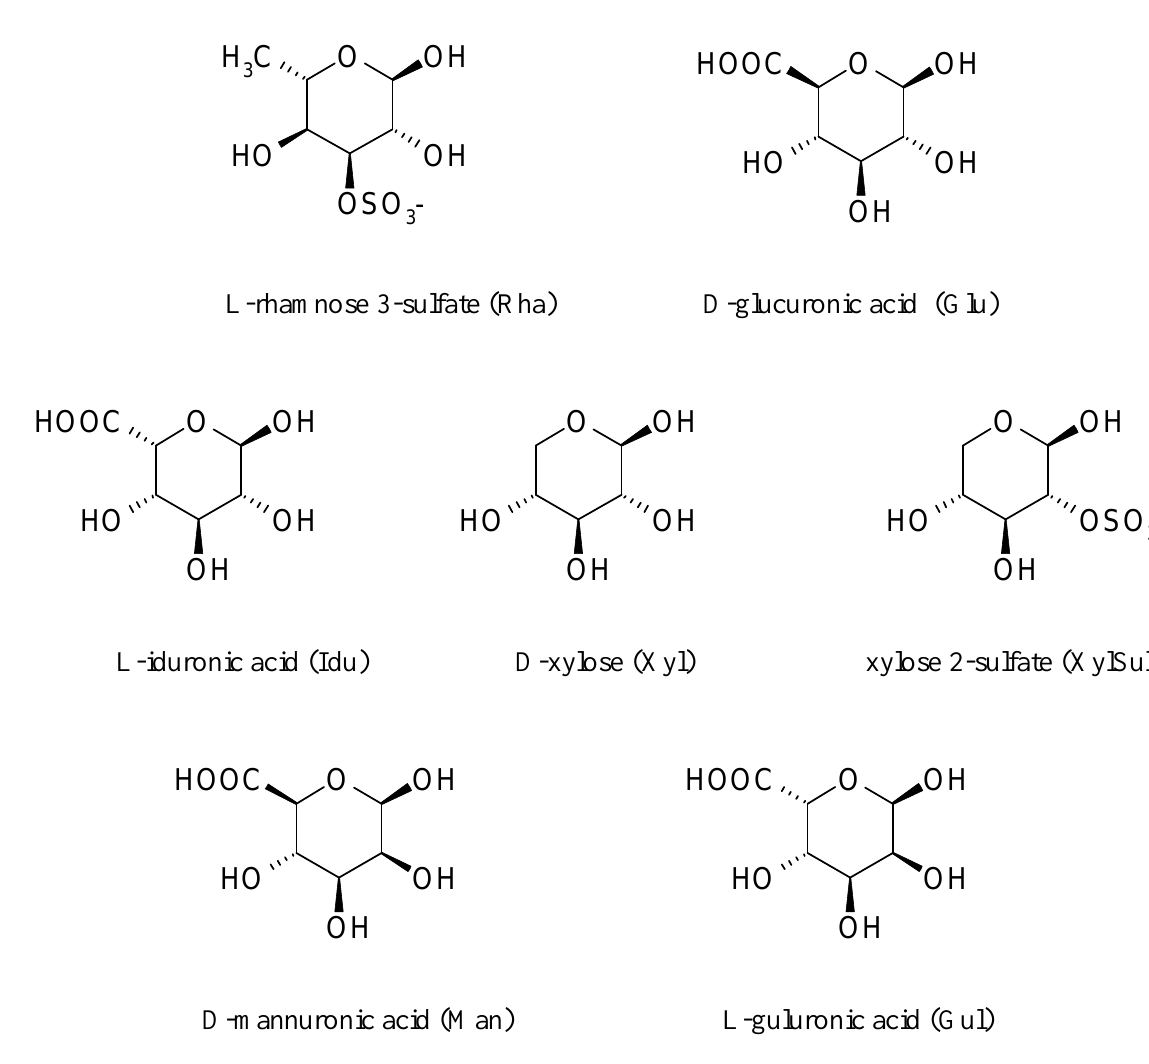
Figure 3. Structure of the monosaccharides deriving from alginates and